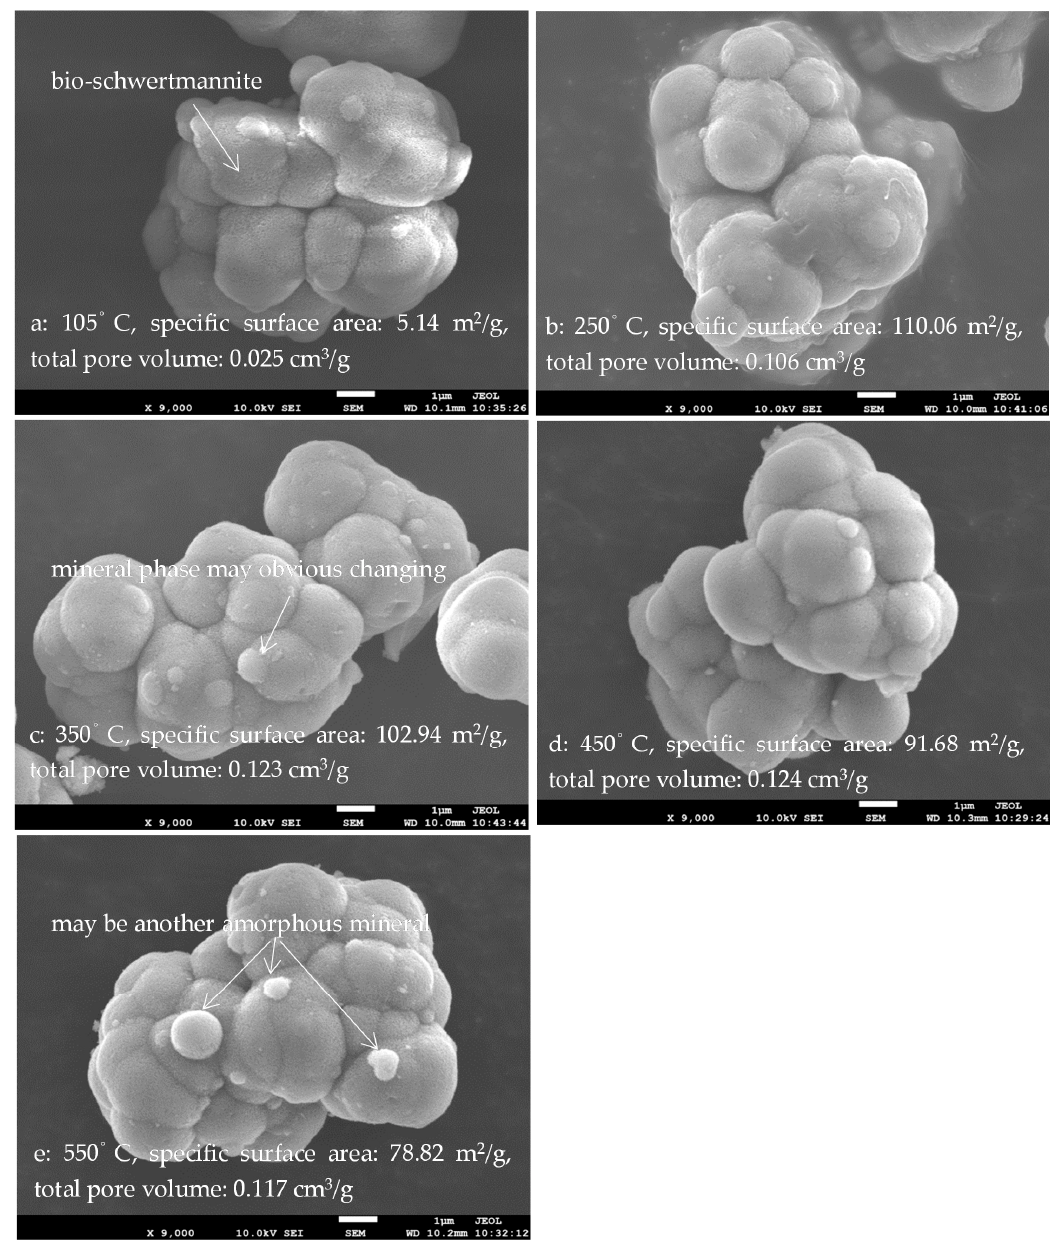
Figure 4. Morphology, specific surface area, and total pore volume of bio-schwertmannite before and after